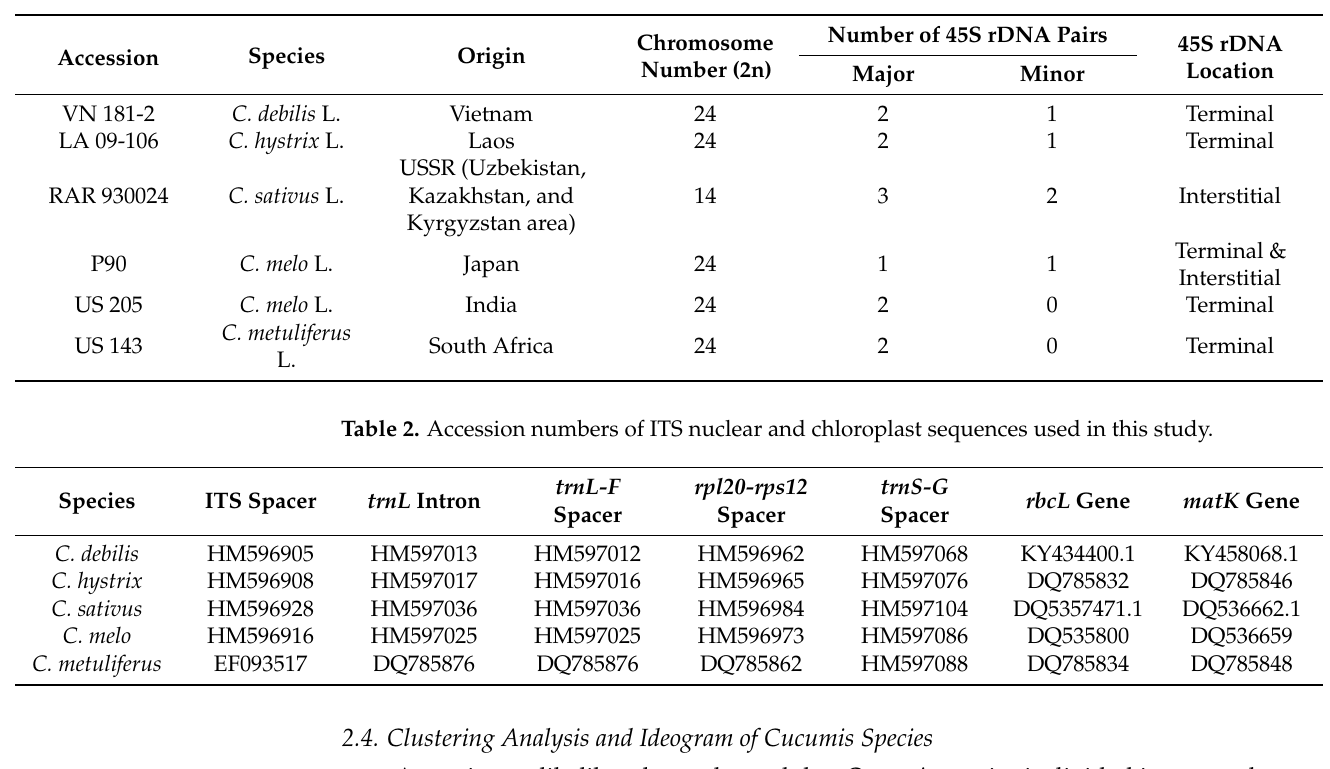
Table 1. Species origin and chromosomal location of 45S rDNA in several Cucumis accessions.